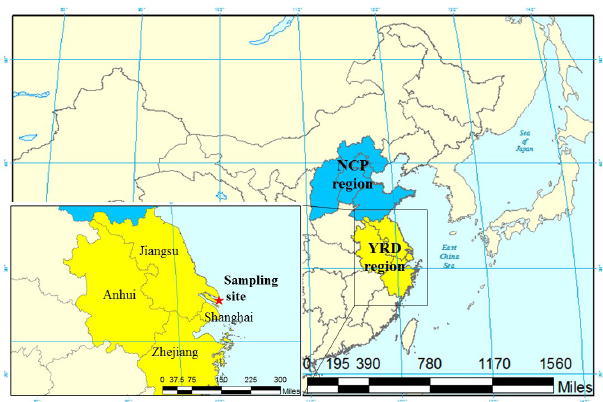
Figure 1. The location of the Chongming monitoring site in Shang- hai,